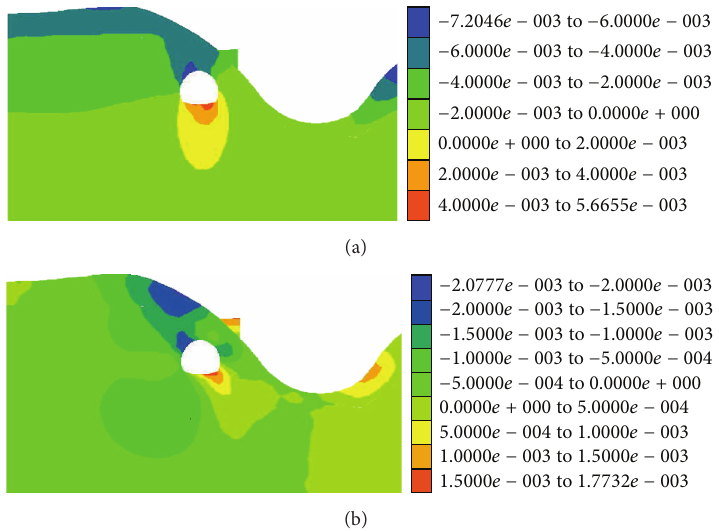
Figure 15: Displacements at section ZK49+883 when the influences of rainfall and creep were not considered: (a) vertical displacement; (b) horizontal